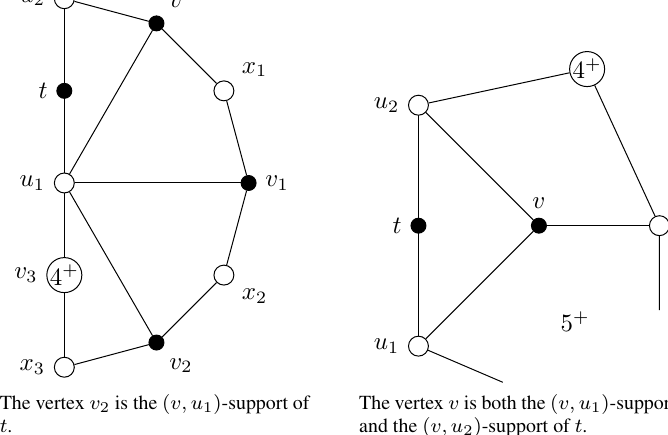
Fig. 1: Examples of